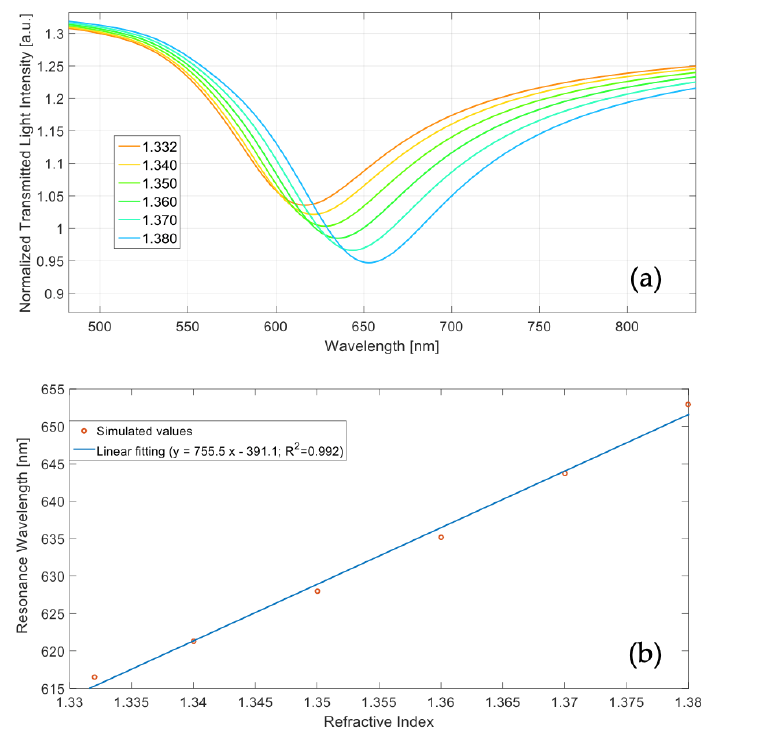
Figure 14. ( a ) Simulated surface plasmon resonance (SPR) transmitted spectra at varying of the external refractive index. ( b ) Resonance wavelength versus refractive index and linear fitting of the simulated